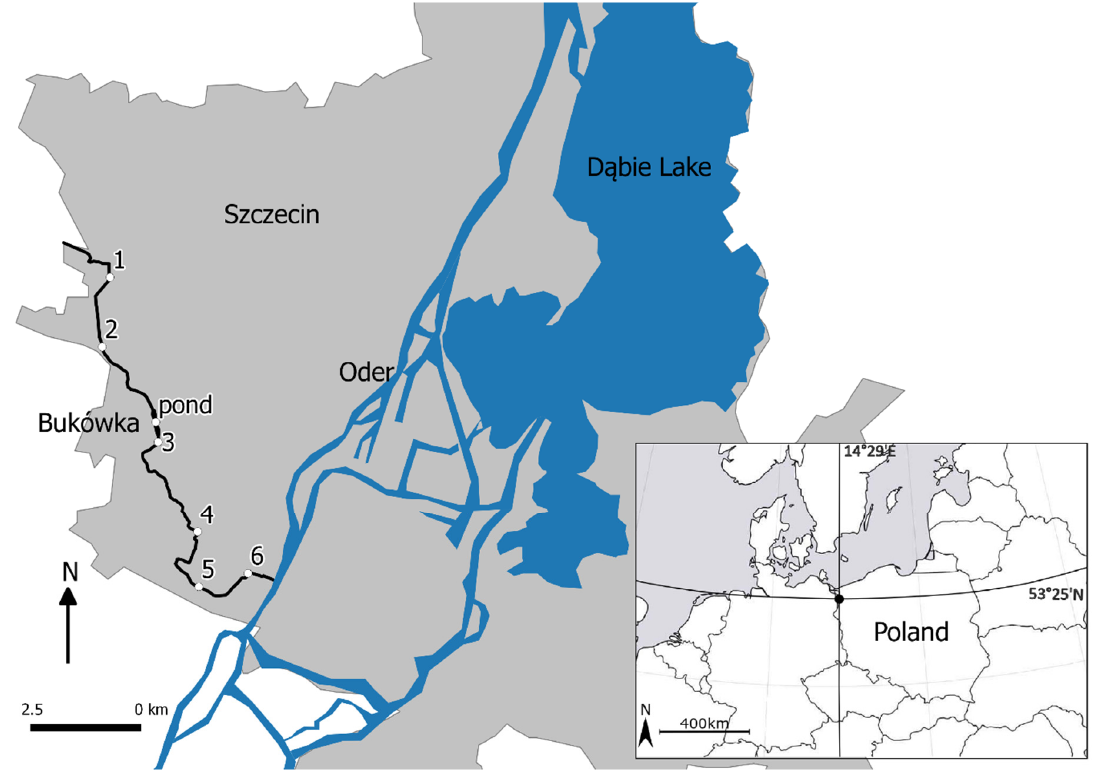
Figure 1. Study area. Numbers on the Bukówka stream indicate the sampling sites.